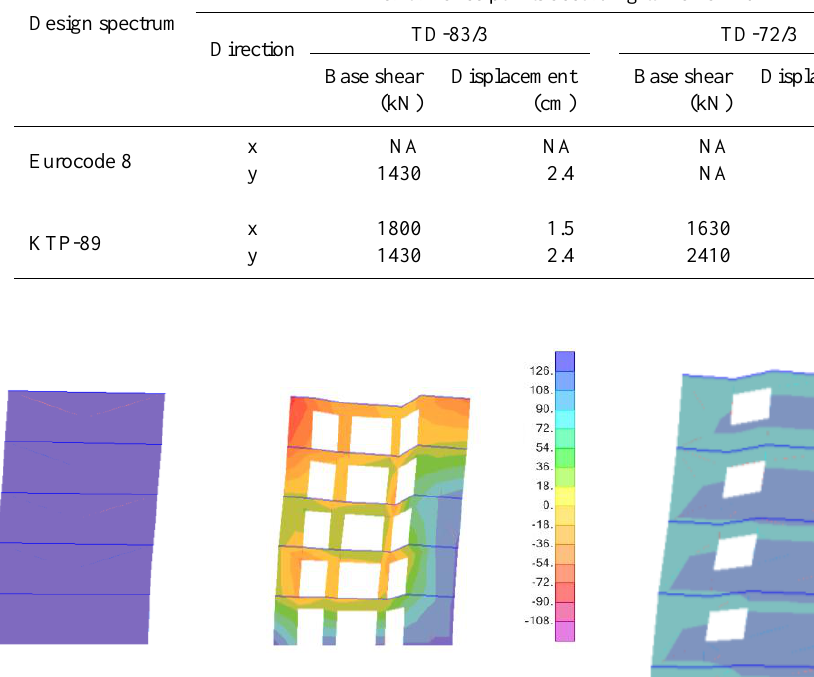
Fig. 13. Ultimate level of shear stress distribution for (a) a peripherial wall element; (b) one wall with opening of TD-72/3 building obtained from pushover analysis (x- direction - kPa) Fig. 14. Ultimate level of shear stress distribution for TD-72/3 building obtained from pushover analysis (y-direction – kPa)